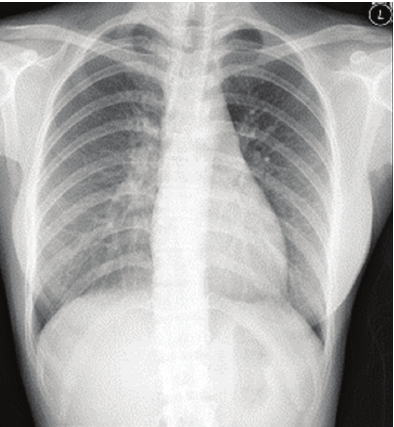
Figure 4: Follow-up chest film at 3 months after treatment. Mediastinum and both hilar nodes appeared normal. Note a decrease in size of superior mediastinal node (5.2 cm) and both hilar nodes (2.0 × 5.9 and 4 × 2 cm).